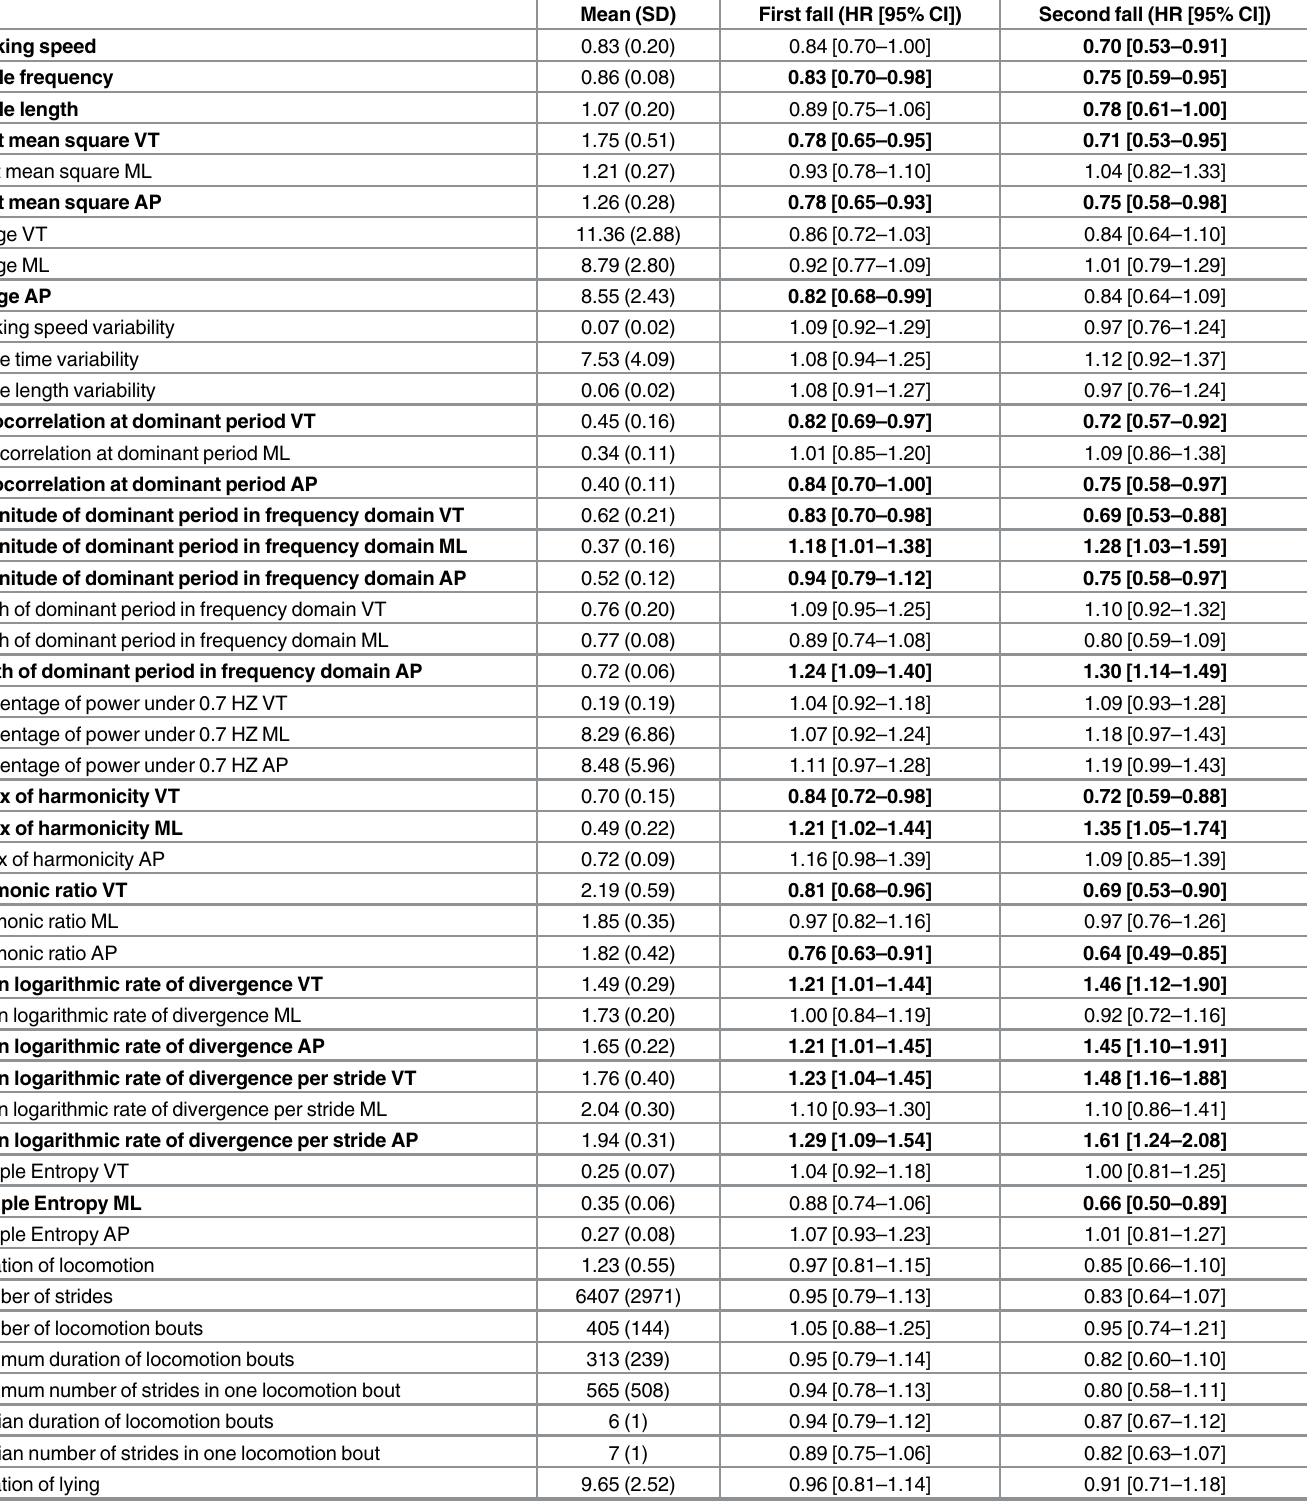
Table 2. Univariate associations between gait quality and physical activity with